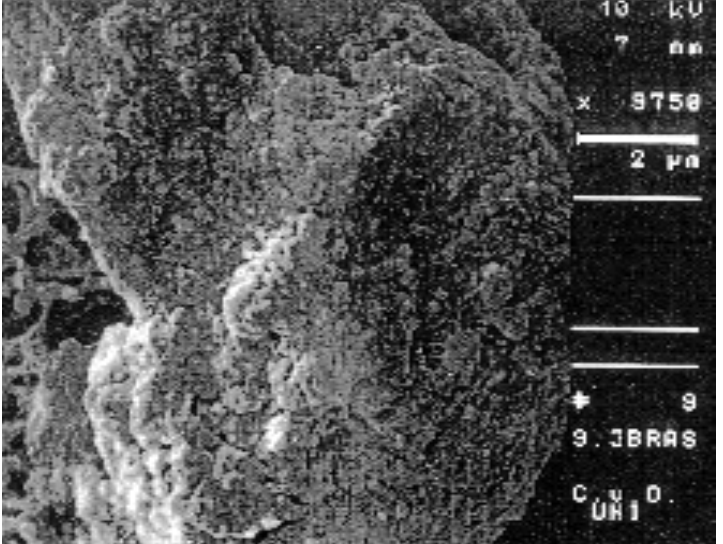
Figura 5. Fotografia obtida por microscopia eletrônica de varredura, mostrando pseudomorfoses de vermiculita intemperizada da biotita, para caulinita, no horizonte 2Btn do perfil 9